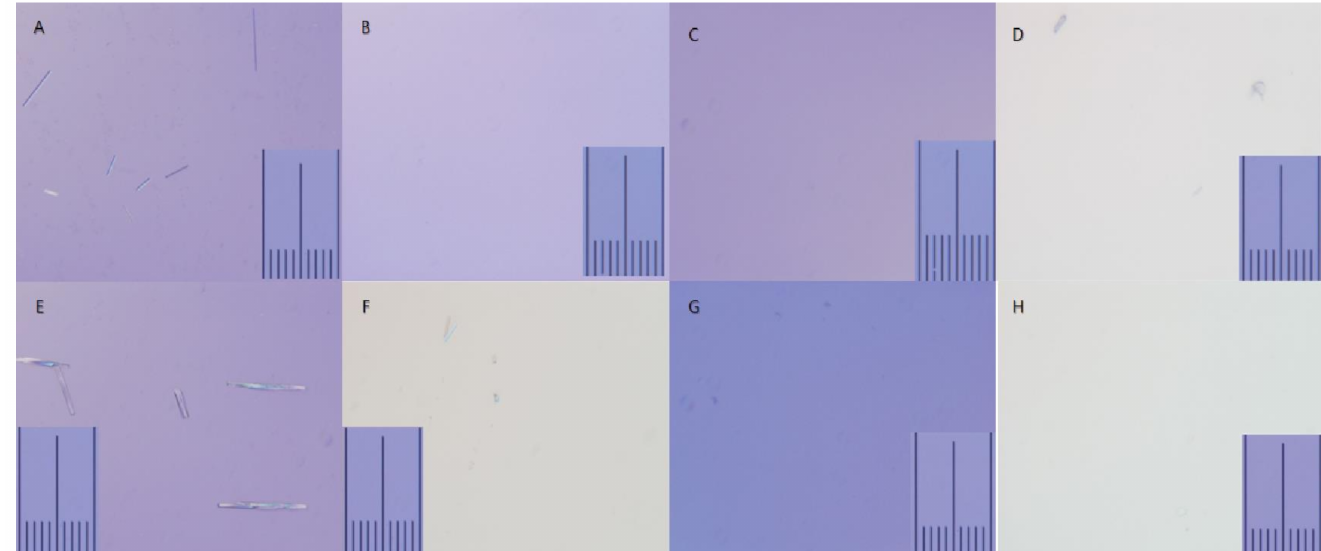
Figure 2. Microscopic findings of dexamethasone, ropivacaine, and contrast media. When ropivacaine was mixed with dexamethasone, particulates were formed ( A , E ). When the contrast media was mixed with the mixture or the temperature was increased to 36 ◦ C, particulates were reduced or